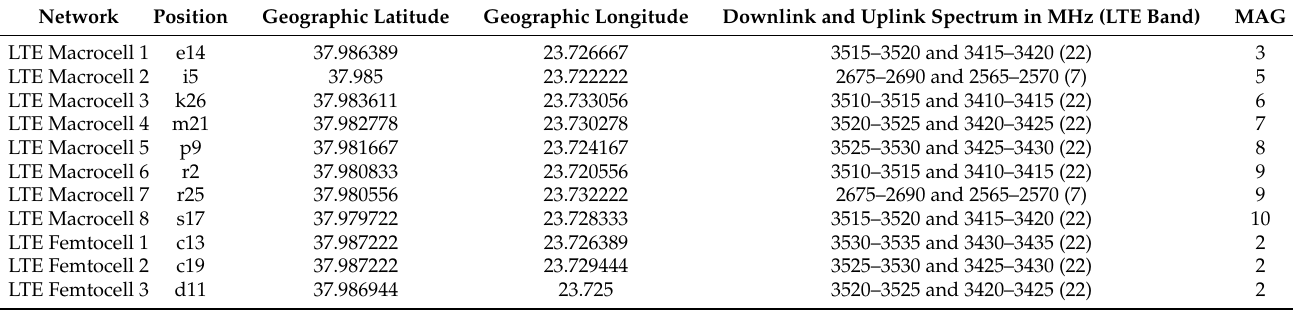
Table A3. The positions and the frequencies of the simulated LTE-A